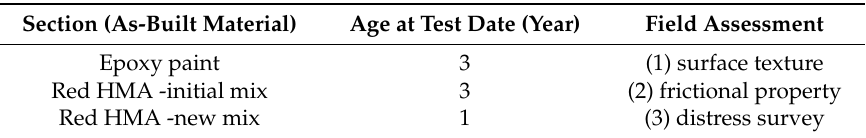
Table 1. Information of tested sections.